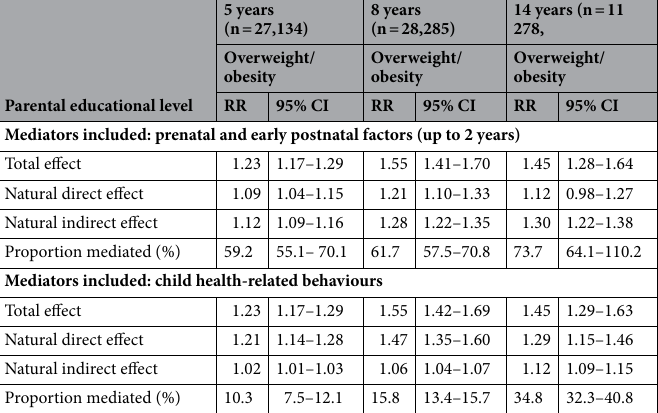
Table 3. Total, direct and indirect effects of parental education on OW/OB at ages 5, 8 and 14 years, in the MoBa study. All models were adjusted for ethnicity and maternal civil